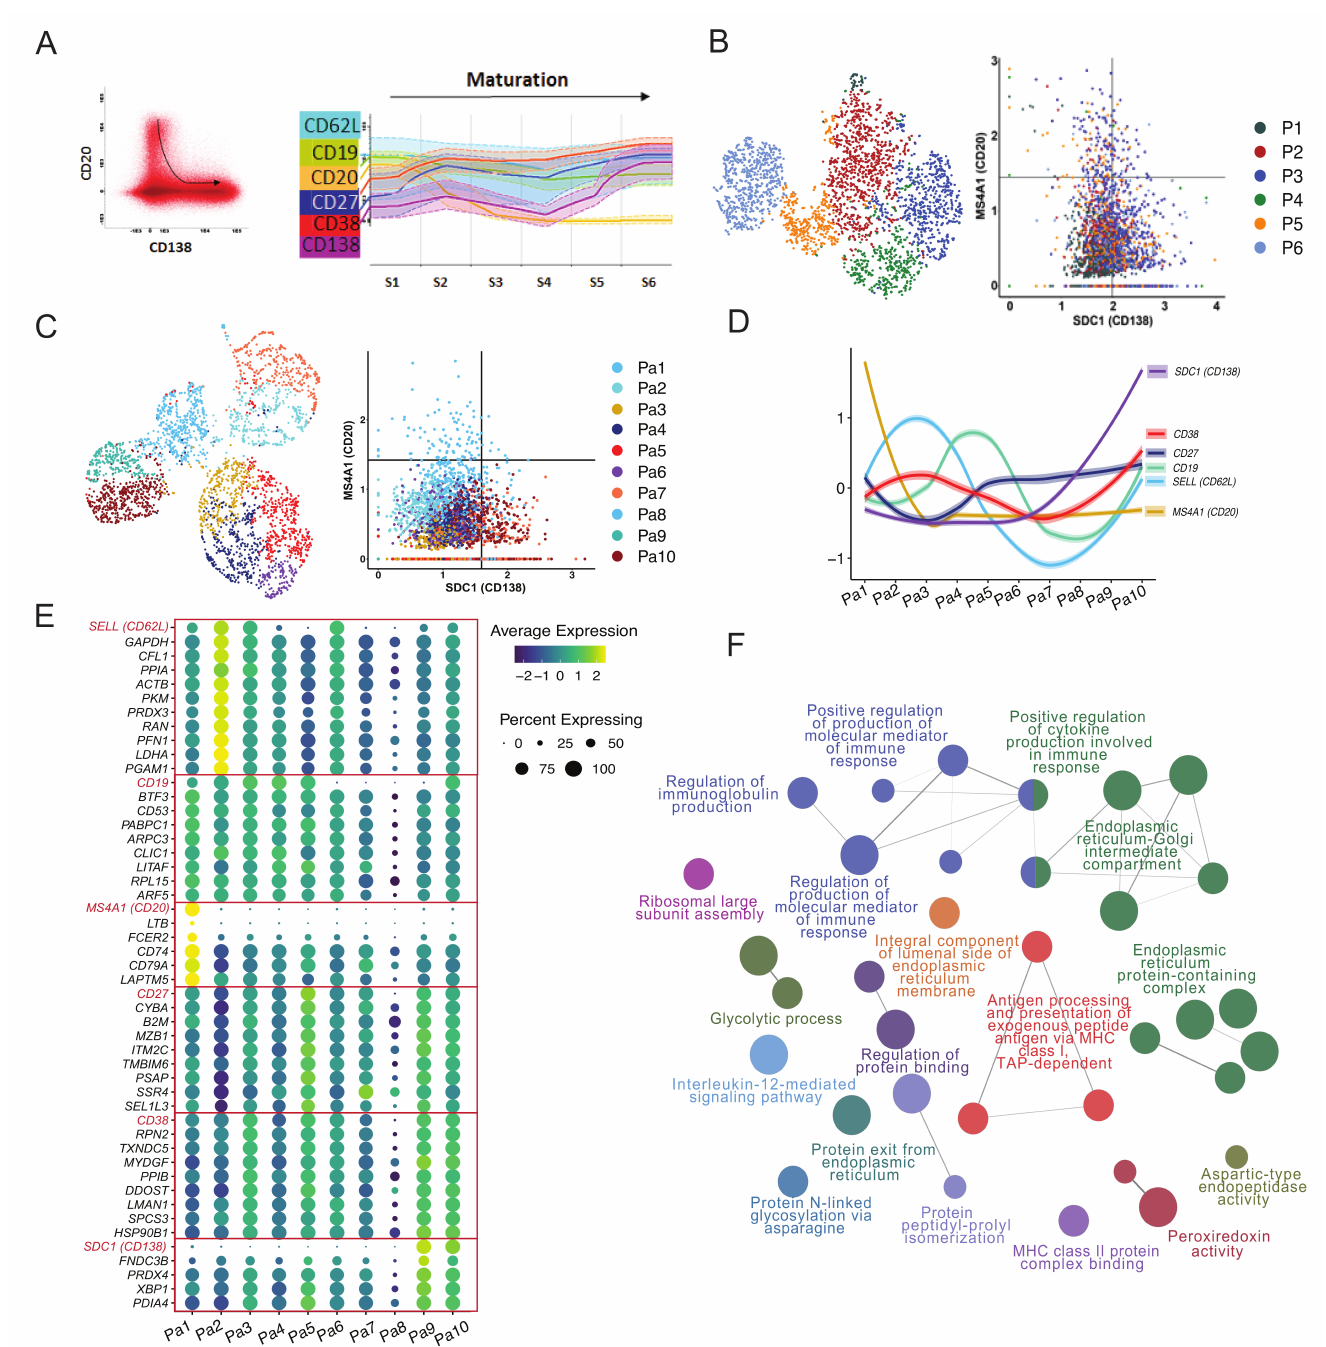
Figure 2. Plasmablast/plasma cell maturation using flow cytometry and single-cell transcriptomics data over time following vaccination. ( A ) Flow cytometric evaluation of cell surface markers in maturing PB/PCs. Plasma cell maturation pathway was drawn in the Infinicyt software based on the surface expression of CD20 and CD138. The least mature PB/PCs were defined as CD20+CD138- and the most mature as CD20-CD138+. Dot plot in the left panel shows all PB/PCs from the same donor and time-points used in the sequencing, and black arrow indicates the direction of plasma cell maturation Each dot represents one cell. Subsequently, the entire maturation pathway was divided into 10 maturation stages (S1–S6), for which expression of additional cell surface markers was evaluated (right panel). ( B ) FACS-like plot to arrange PB/PCs clusters P1-P6 in the maturation pathway defined by the expression of CD20 and CD138. ( C ) Redefining stages of PB/PCs in single-cell transcriptome data using six markers pre-selected based on flow cytometry. The PB/PCs were clustered using six pre-defined maturation markers and FACS-like plotting is used to stage the plasma cell clusters based on the maturation pathway. Ten clusters i.e., Pa1-Pa10 were obtained. ( D ) The spaghetti plot of all six markers visualized after staging